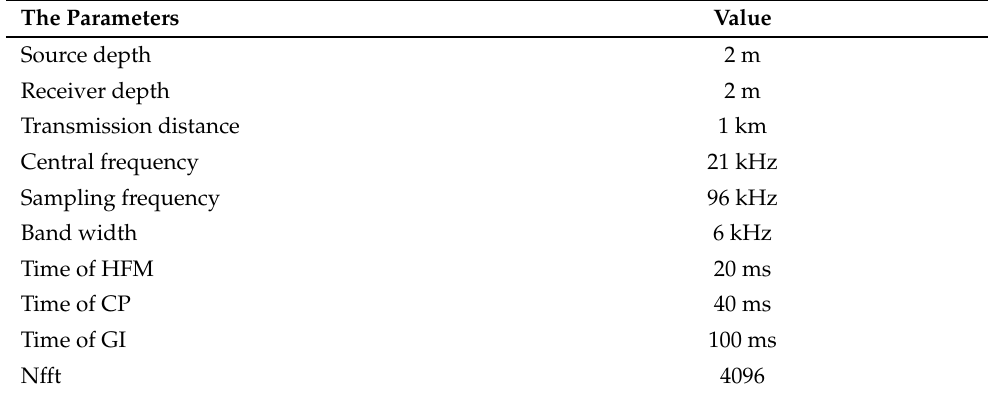
Figure 10. Comparison of the transmitted figure and the reconstructed figure. Table 4. The environmental